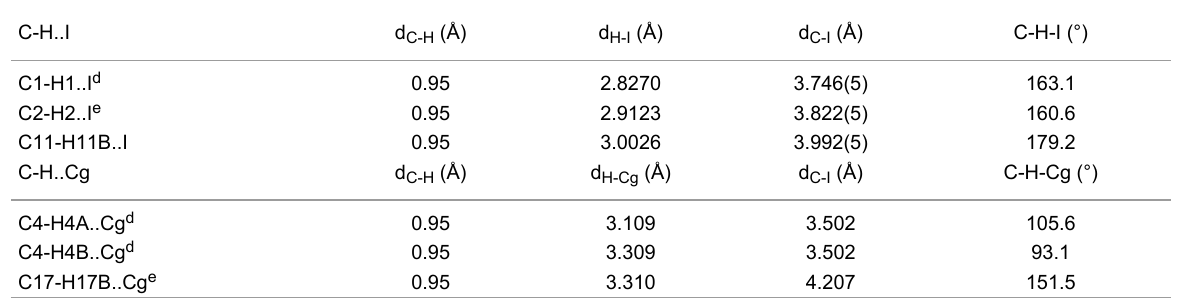
Table 1: Non-classical hydrogen bonds and CH..π interactions a occurring in 1a . Cg is the phenyl ring (C5 to C10). Symmetry operators for equivalent positions: d = ±1+x, y, z; e = 1+x, 1+y, z.